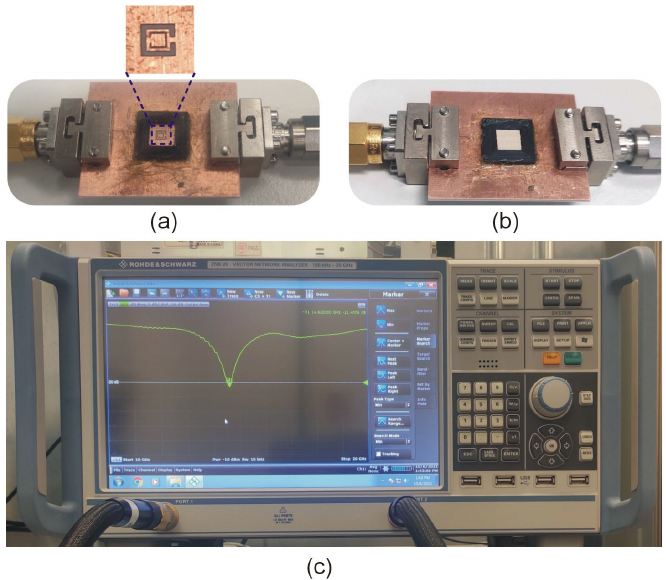
Figure 11. Photographs of the SC ‐ SRR sensor’s fabricated prototype: ( a ) bottom view with PLA container and the optimized CSRR, ( b ) sensor with MUT, and ( c ) Vector network analyzer (VNA) while measuring the unloaded sensor.